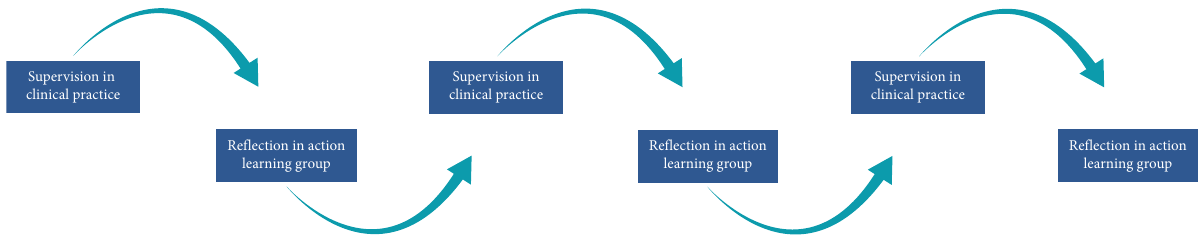
Figure 2: Back-and-forth movement between practice and reflection. Table 2: Understanding and use of the Model of Practical Skill Performance. Very much, % Much, % Some, % A little,